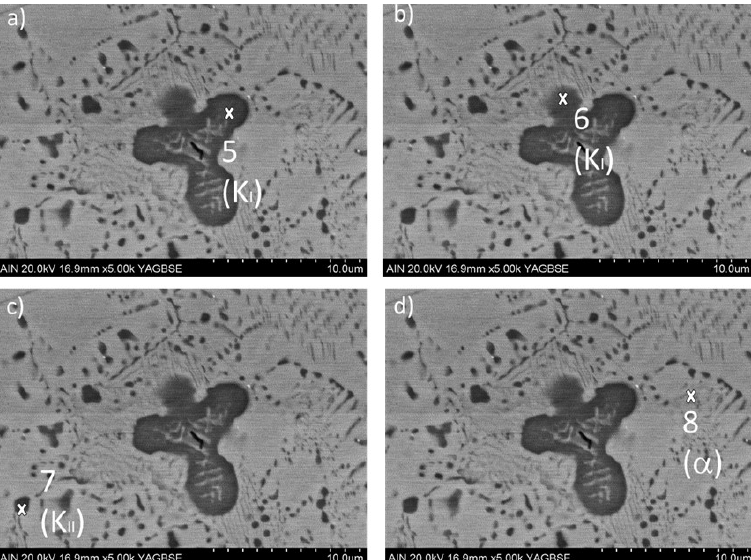
Figure 3. Backscattered electron (BSE) micrographs of the NAB alloy B with the presence of the different Kappa intermetallic compounds with their corresponding morphology such as rosette (a, b), spheroidal (c) and alpha phase (d) with their corresponding area locations for the EDX compositional chemical analysis in the NAB alloy B.